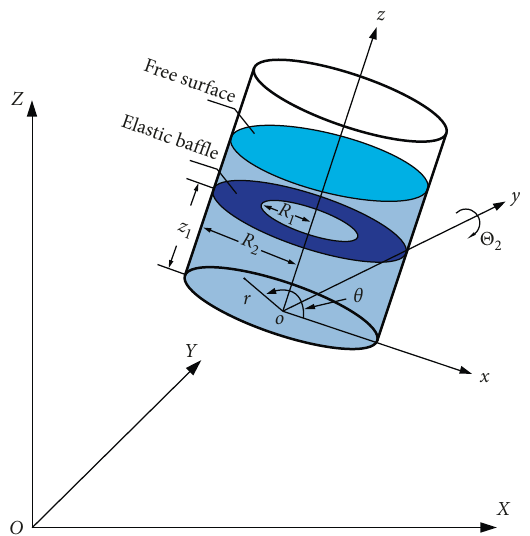
Figure 1: Cylindrical container with single elastic baffle under pitching